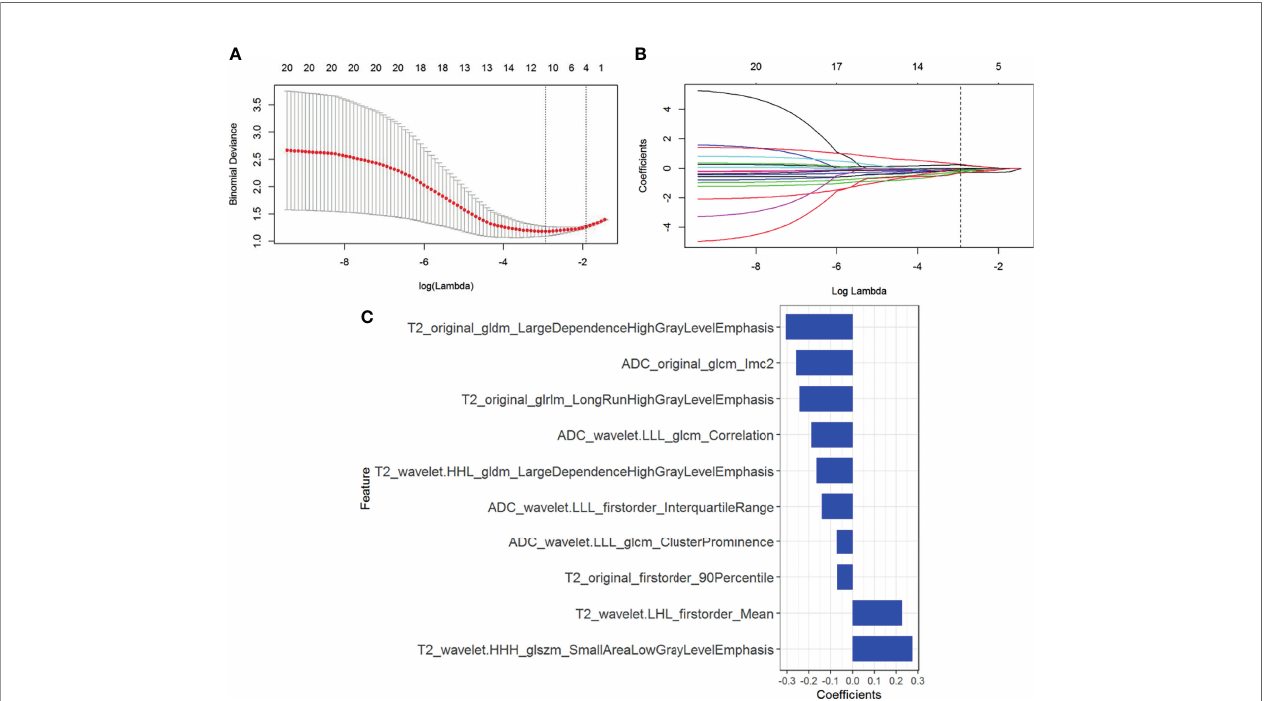
FIGURE 3 | Radiomics feature selection using the least absolute shrinkage and selection operator (LASSO) regression. (A) Tuning parameter ( l ) selection in the LASSO model. The optimal value of l = 0.053, with log( l ) =-2.937 was selected. (B) LASSO coef fi cient pro fi les of the N radiomics features. A coef fi cient pro fi le plot was generated versus the selected log ( l ) value with 5-fold cross validation. (C) The selected radiomics features (with nonzero coef fi cients) and their coef fi